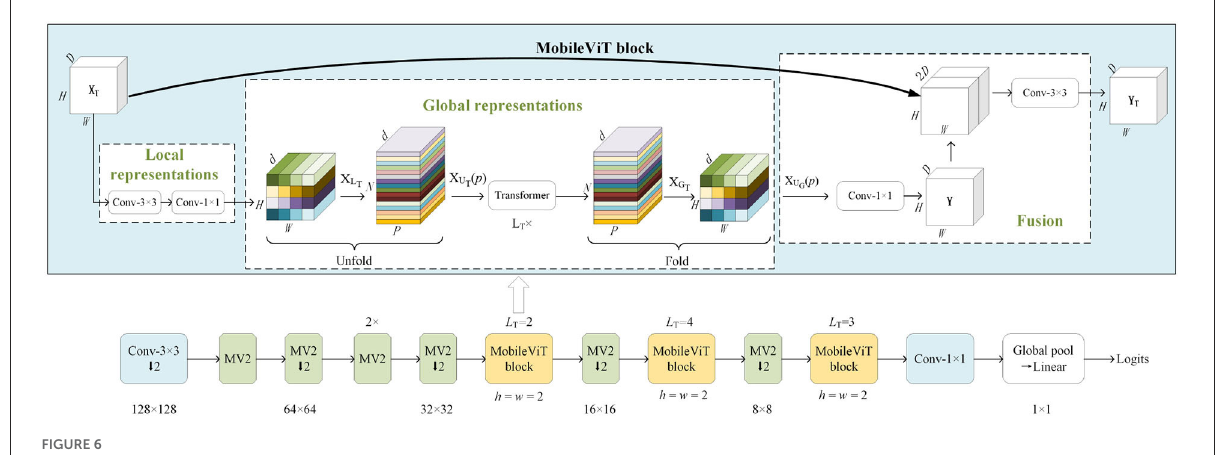
FIGURE6 The architecture of Mobile ViT network.